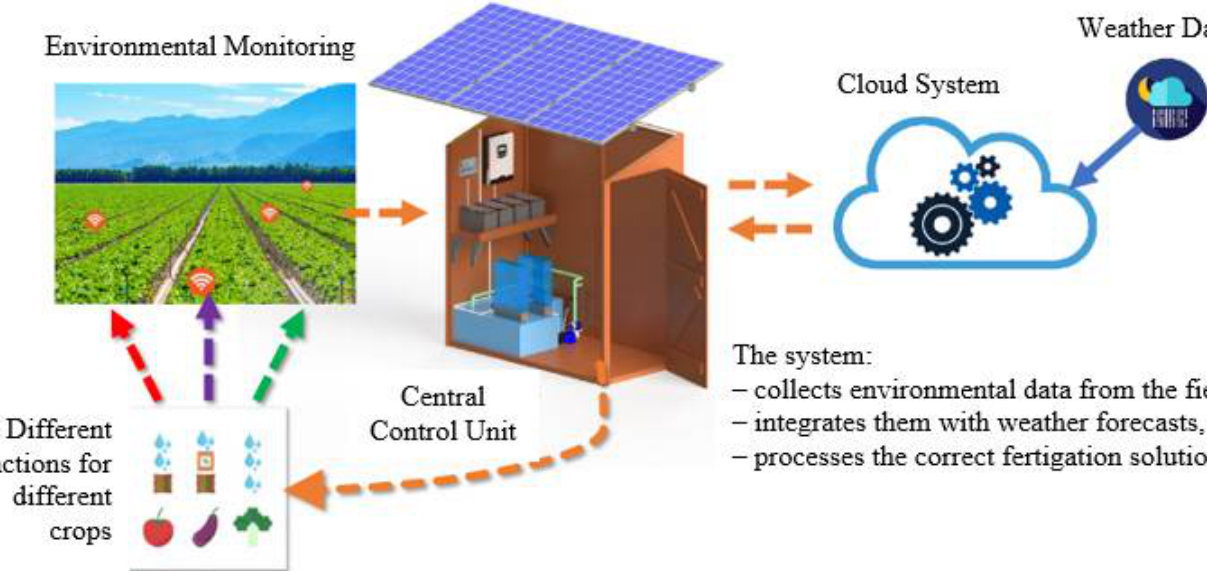
Figure 1. Flow diagram of the architecture of the proposed system.